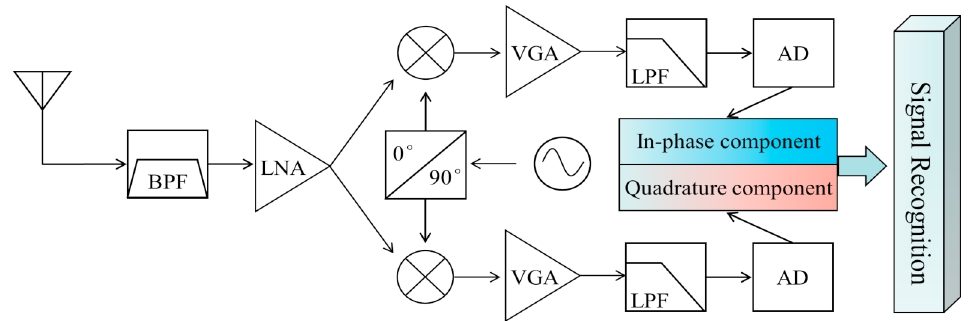
Figure 1. Quadrature sampling zero-IF intelligent